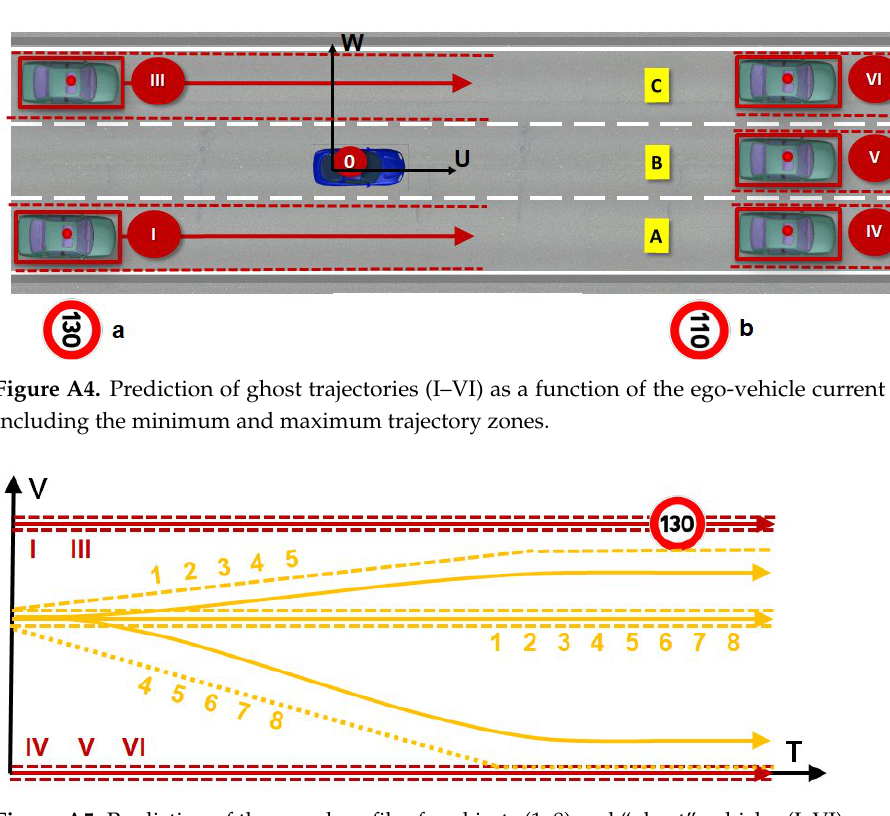
Figure A5. Prediction of the speed profiles for objects (1–8) and “ghost” vehicles (I–VI) as a function of the ego-vehicle position